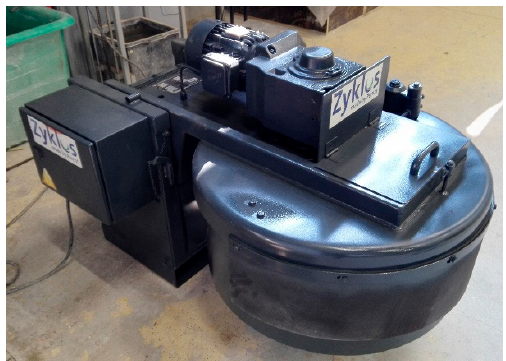
Figure 3. Pan mixer (50 L capacity).